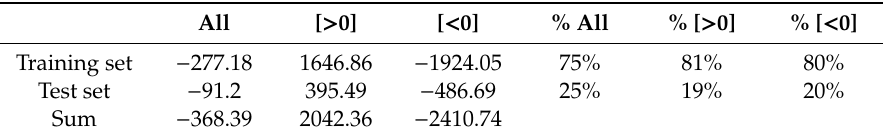
Table 2. Value characteristics of training set and test set.